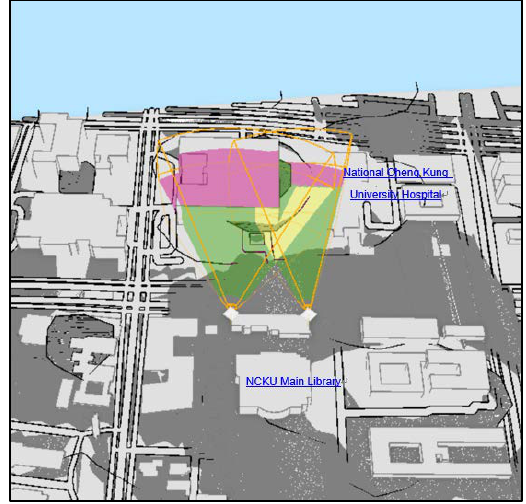
Figure 3. 3D FOV CCTV monitor field of view for area A. After the height information of the CCTV and buildings are considered, the analysed outcomes appear to be significantly different. The area visible by both CCTVs is illustrated with the colour of yellow, while the area only visible by one CCTV is illustrated with the colour of green, and the area not visible is illustrated with the color of red. Unlike the outcomes in Figure 2, one major difference is the roof of the building is not visible due the height difference of the CCTV and buildings. Some of the multiple coverage area is actually on the wall of the building and not limited to the ground. This clearly show the limitations of the 2D FOV analysis and the advantages of the 3D FOV approach.